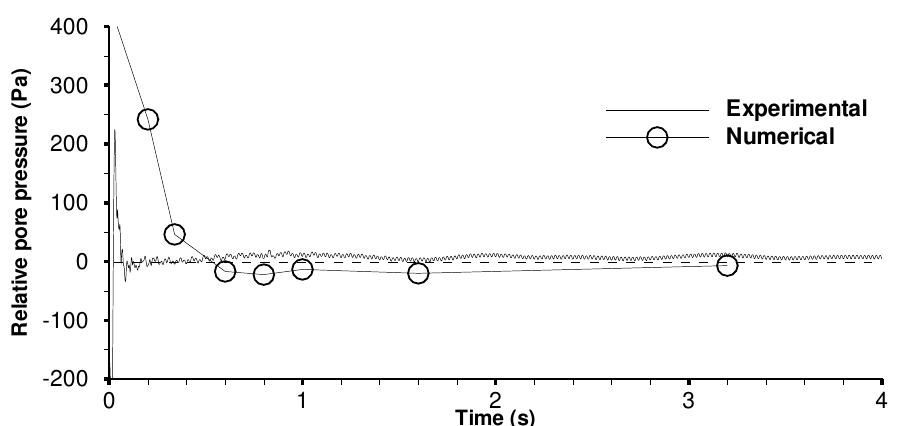
Figure 16. Relative pore water pressure at point P 1 during the collapse process of an initially loose packing granular